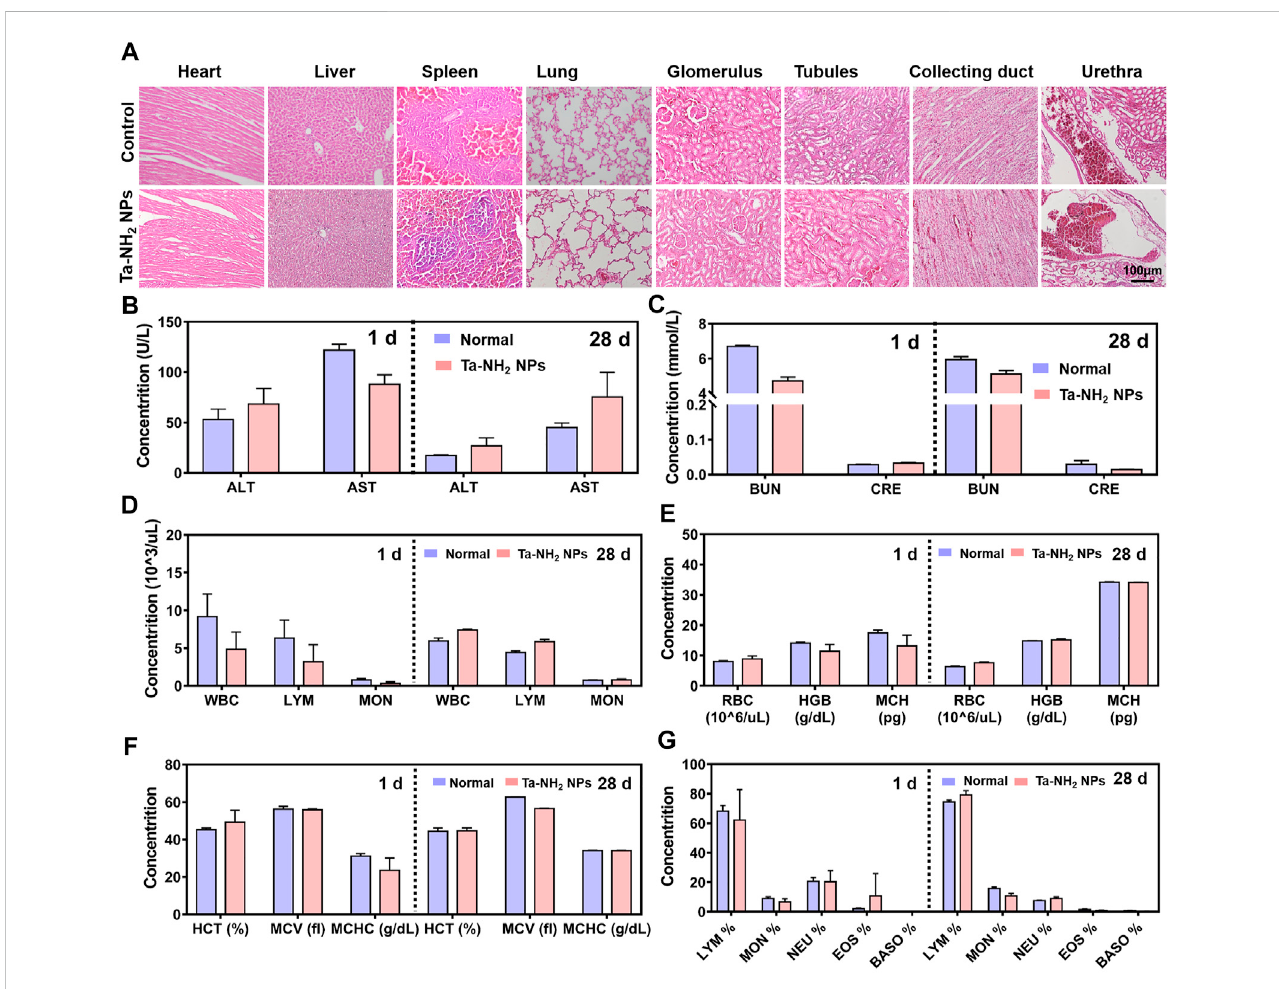
FIGURE 6 In vivo biocompatibility assessment of Ta-NH 2 NPs. (A) . Evaluation of in vivo toxicity of Ta-NH 2 NPs to major organs (heart, liver, spleen, and lung) at 1 d after knee joint injection. Serum levels of liver function indicators: aspartate aminotransaminase (AST) and alanine aminotransaminase (ALT) 1 d and 28dafter injection (B) .Serumlevelsofkidneyfunctionindicators:bloodureanitrogen(BUN)andcreatinine (CRE)1dand28dafterinjection (C) . (D – G) Blood parameters in normal rat and rat knee joint injected with Ta-NH 2 NPs 1 d and 28 d after injection. In (B – E) , data were represented as means ± s.d., from three independent